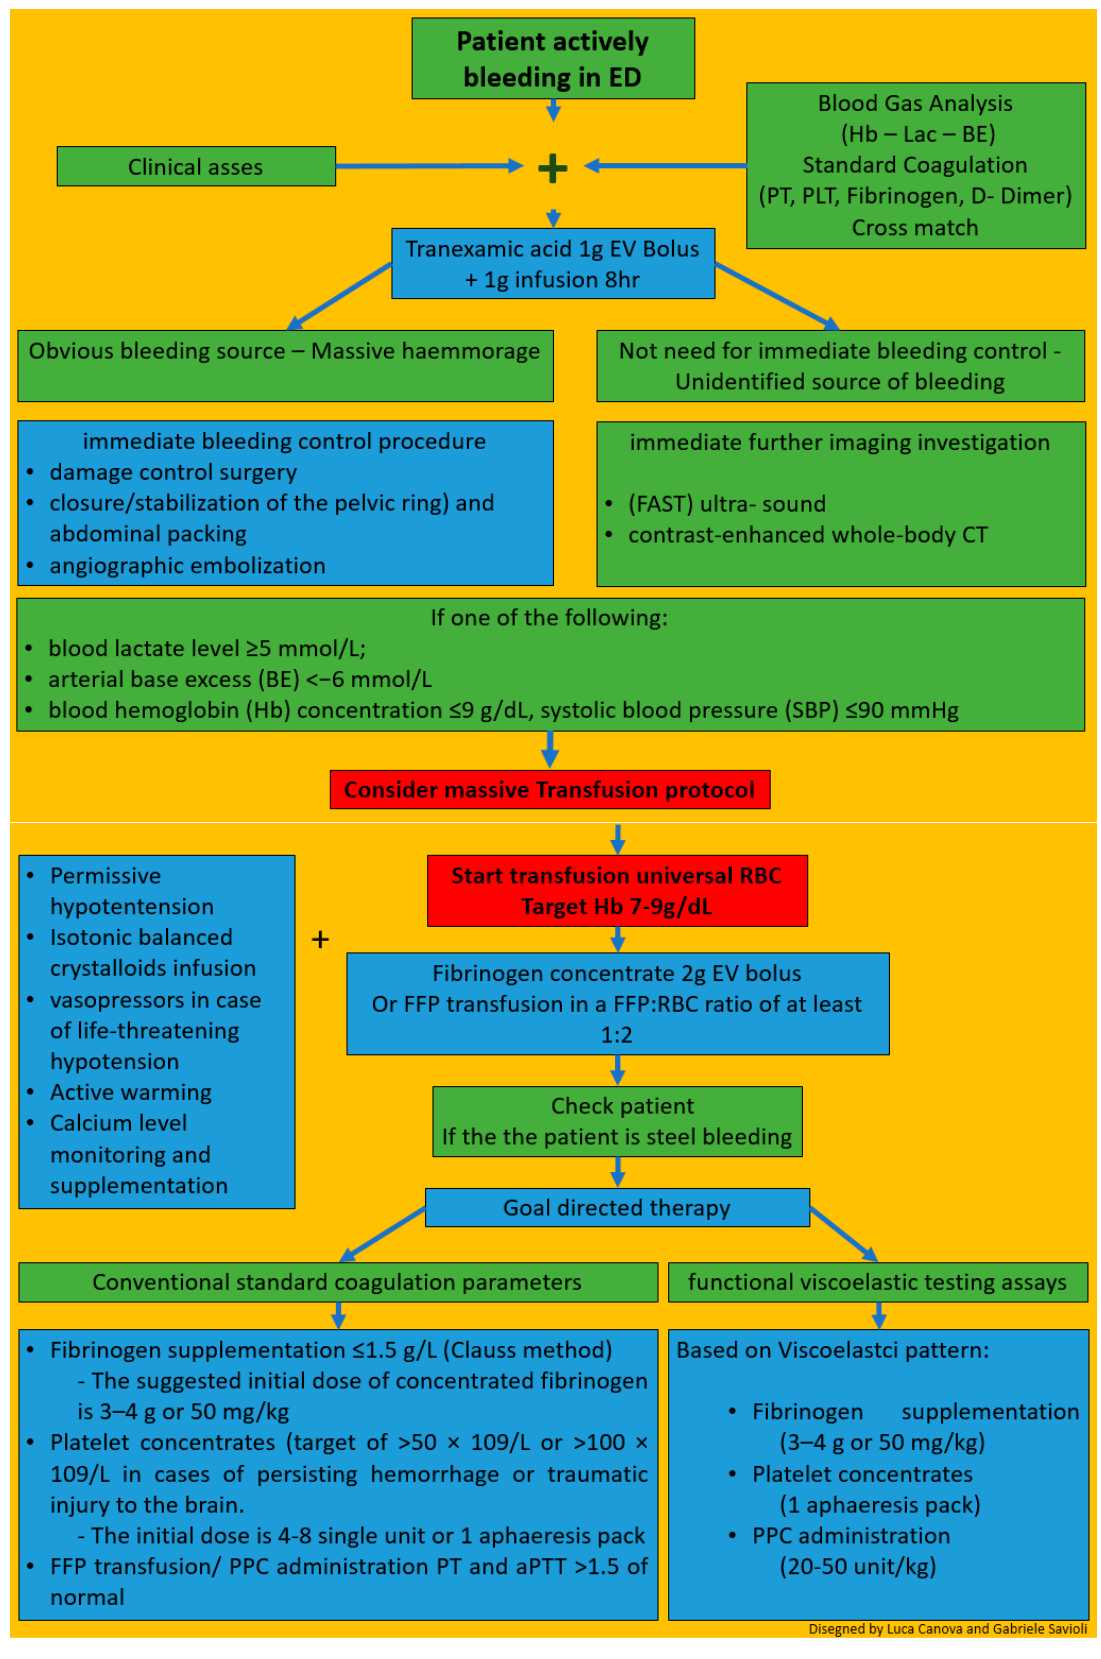
Figure 6. Overview of hints for therapy.